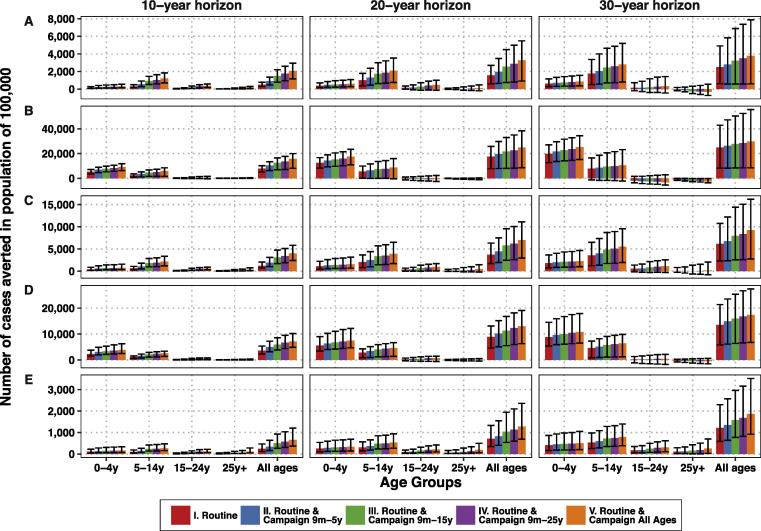
Model predictions for the cumulative number of cases averted over 10, 20, and 30 years following vaccine introduction in four age groups and in the whole population for (A) Kolkata, (B) Delhi, (C) Dong Thap, (D) Nairobi, and (E) Lwak. Note that the scale of the y-axis varies for each location. The colored bars represent the mean model predictions, while the black error bars represent the uncertainty from the transmission model parameters. (For interpretation of the references to colour in this figure legend, the reader is referred to the web version of this article.)